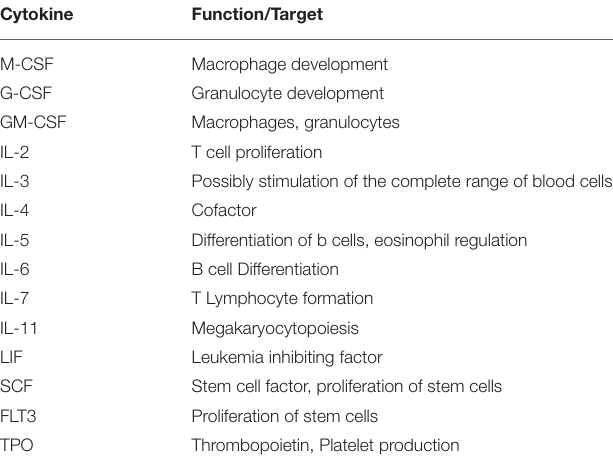
TABLE 1 | Important factors for